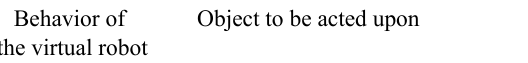
Figure 9. Example action